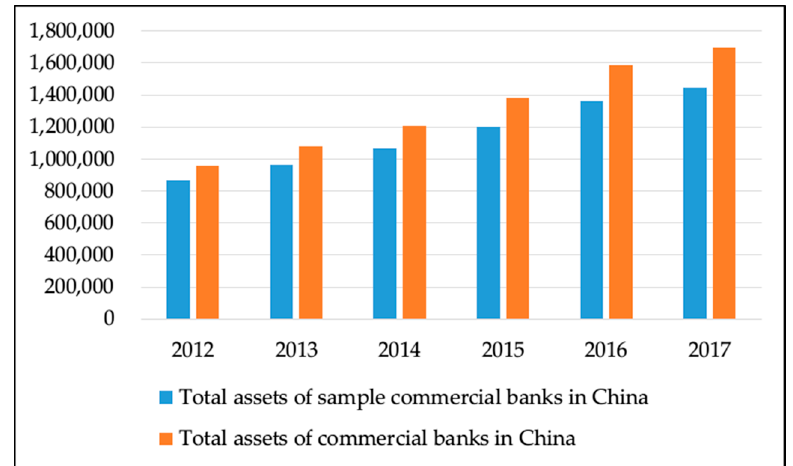
Figure 1. The trends of the total assets (the unit of the total assets is 100 million RMB) of commercial banks (2012–2017).